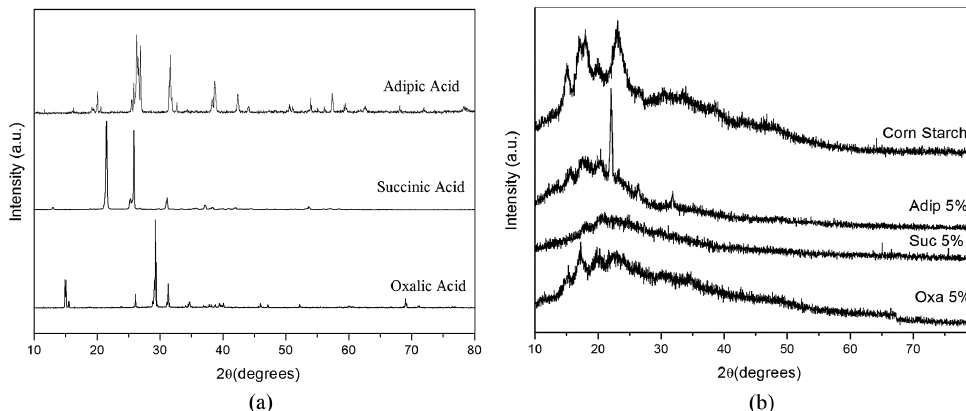
Figure 3. XRD diffractograms of the precursor (a) and biofilms (b).